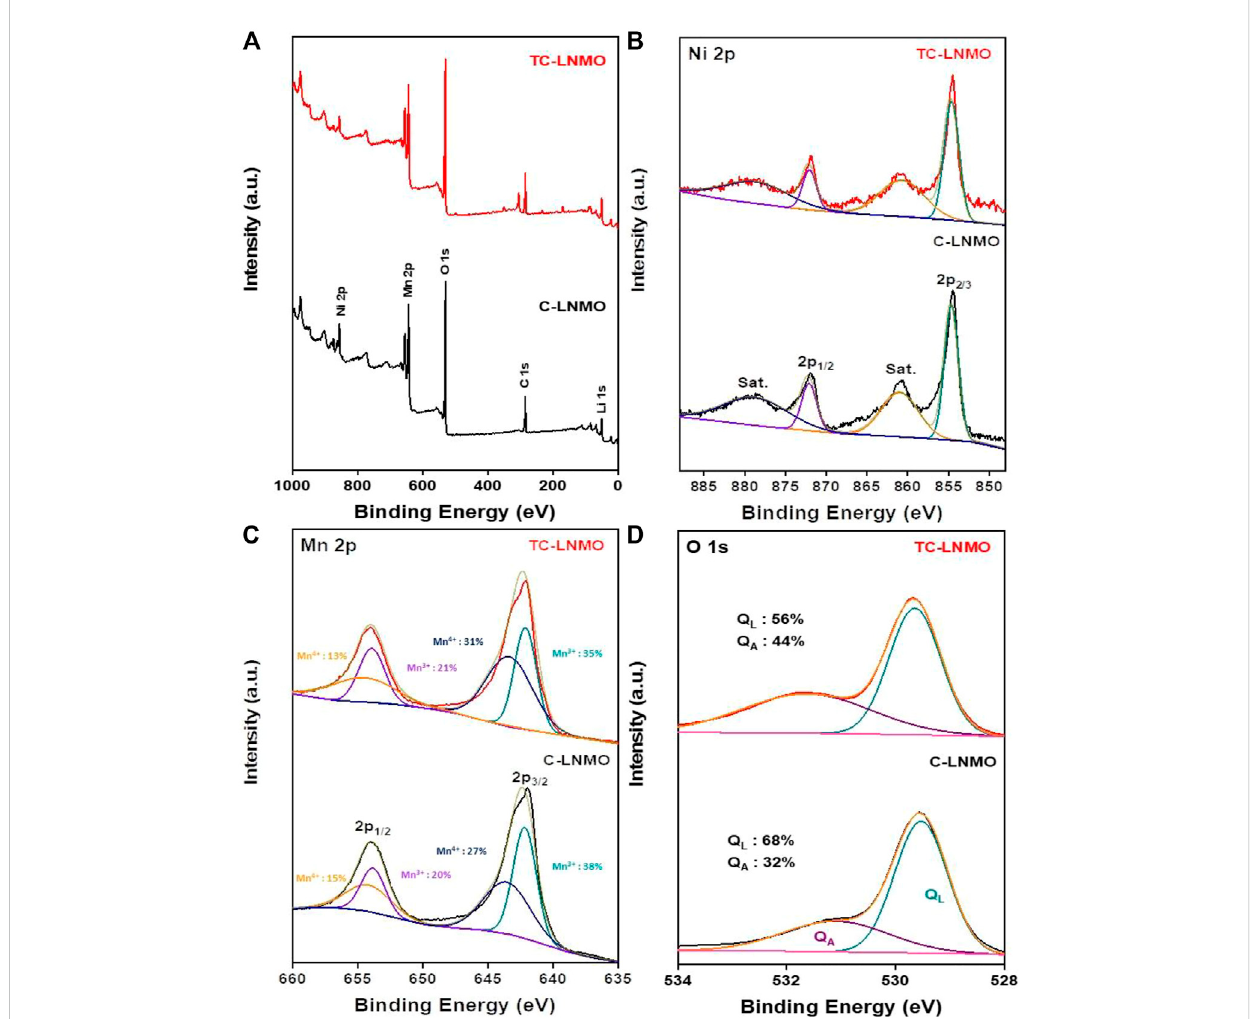
Figure 7A shows the results of the evaluation of the cyclability characteristics of the C-LNMO and TC-LNMO samples at 1 C. The 100 cycle capacity retention rates of the C-LNMO and TC-LNMO samples were 63.8% and 97.7%, respectively, indicating that TC-LNMO had high-capacity retention characteristics. Figure 7B shows the average discharge voltage of the C-LNMO and TC-LNMO samples during 100 cycles. The high electrochemical properties of TC-LNMO are attributed to the higher speci fi c surface area compared to C-LNMO, the hierarchical morphological characteristics, and the proper mixing of Mn 3+ and Mn 4+ shown in XPS. The average discharge voltage is an important factor in measuring the energy density of a battery. The initial discharge voltages of C-LNMO and TC-LNMO were 4.52 and 4.58 V and the 100 cycle discharge voltages were 4.42 and 4.57 V, respectively. TC-LNMO showed a voltage